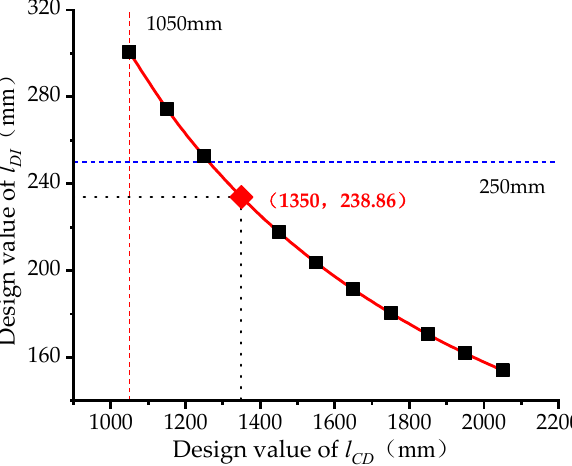
Figure 7. Design of outlet section of the throwing straight pipe section.